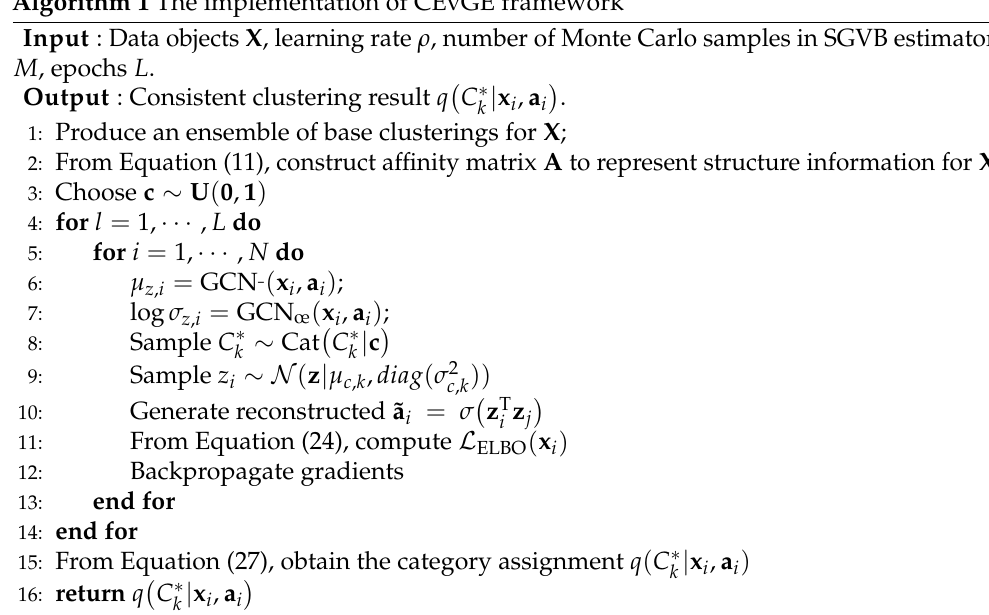
Algorithm 1 The implementation of CEvGE framework